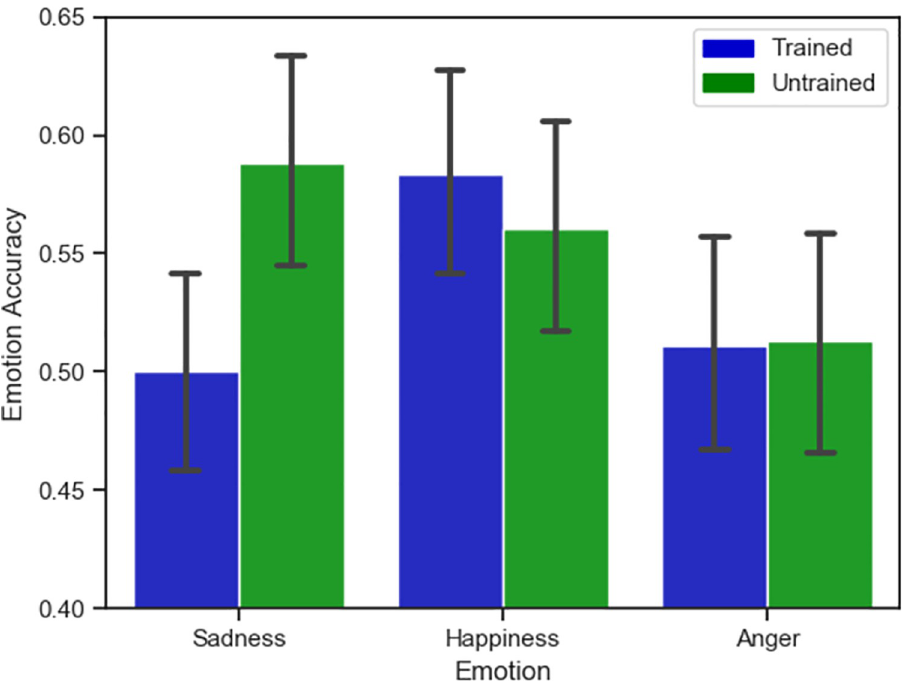
Fig 2. Accuracy results. Emotion Recognition Accuracy depending on Groups and Emotion Categories. Y-axis represents a truncated scale, and error bars represent 95% confidence intervals.